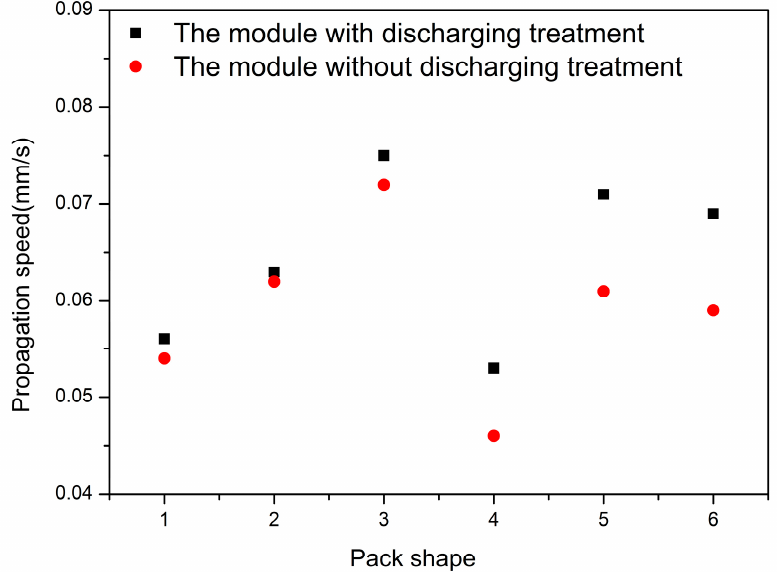
Figure 6. The propagation speeds of packs with various shapes where the numbering 1, 2, 3, 4, 5, and 6 represents the triangle pack, rectangle pack, parallelogram pack, line pack, hexagon pack and square pack respectively.